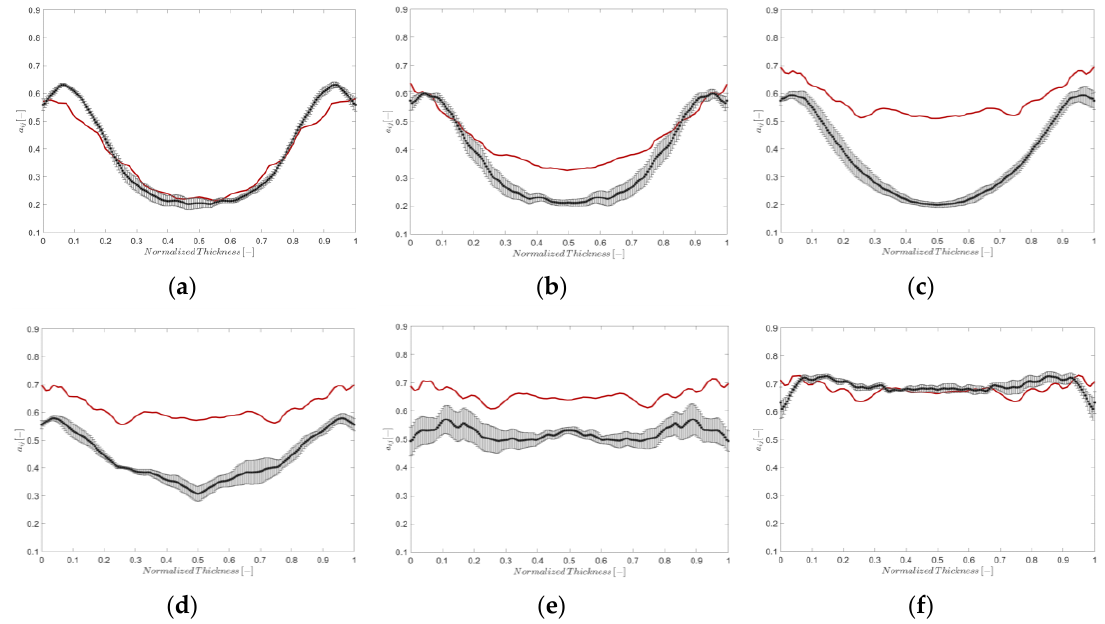
Figure 13. Experimental (black) and predicted (red) a 11 values averaged through sample thickness at varying shear strains for compression molded samples. ( a ) Initial fiber orientation distribution at 0 shear strain, ( b ) fiber orientation distribution after 5 strain units, ( c ) 12.5, ( d ) 20, ( e ) 40, and ( f ) 60 shear strain units [43].